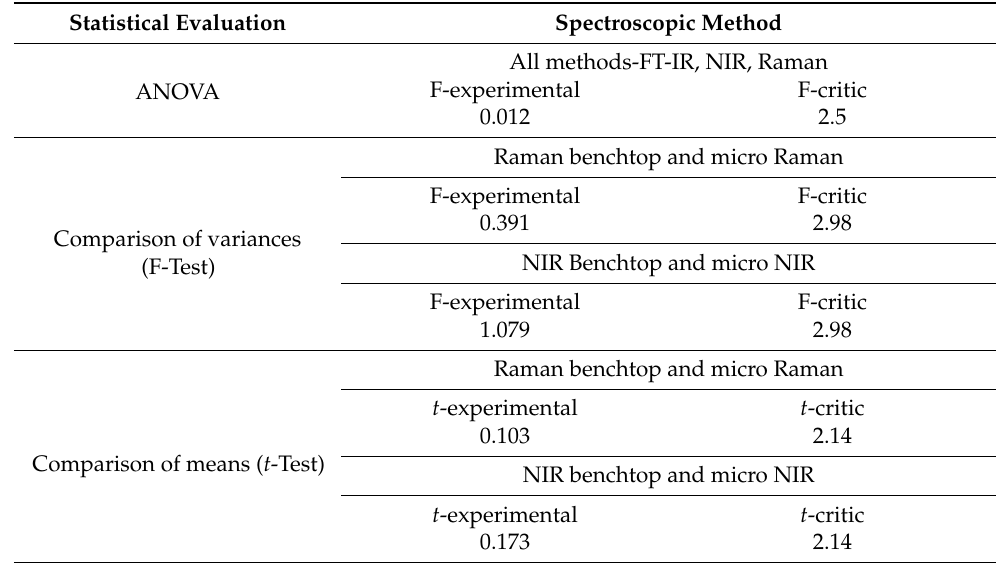
Table 3. Statistical comparison between